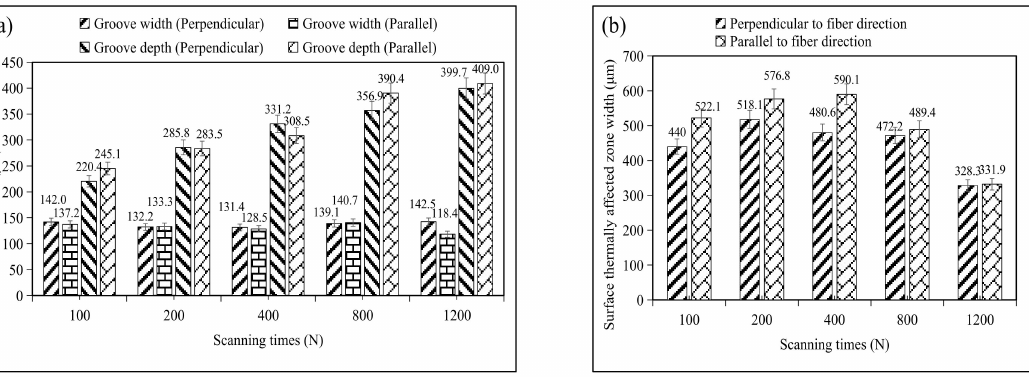
Figure 5. Effect of laser scanning times on the composite surface groove (( a ). variation in groove width and depth; ( b ). variation in thermally affected zone width).